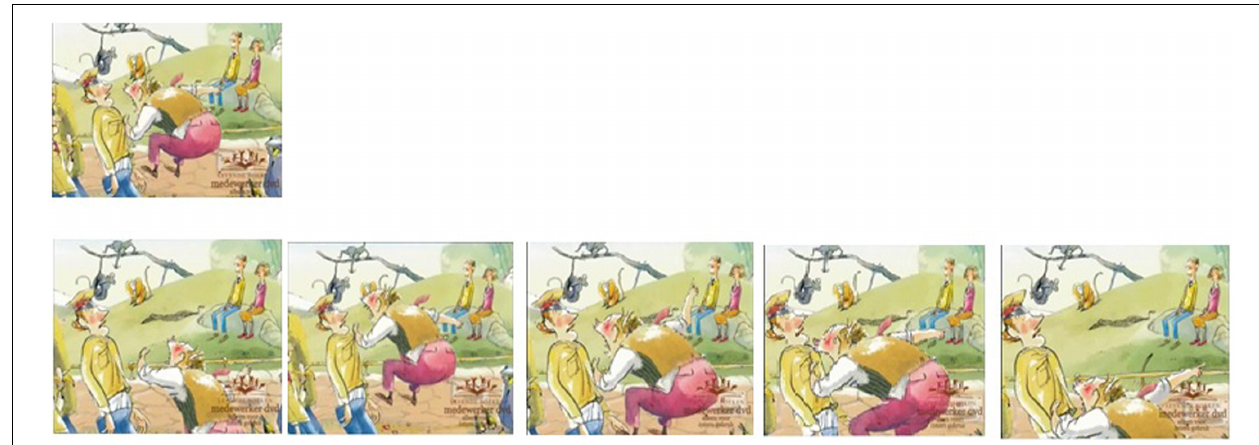
FIGURE 1 | One of the target illustrations chosen for fine-grained analysis of the eye-tracking data. The same illustration in the static condition in the first row and still frames from the animated version are shown in the second row. The director of the zoo is jumping up and down while the accompanying oral text says: ‘These are not monkeys!’ he shouted ∗ jumping ∗ ‘These are people!’. [‘Dit zijn geen apen!’ riep hij “trinnend,” ‘Dit zijn mensen!’. Copyright 2014 by Het Woeste